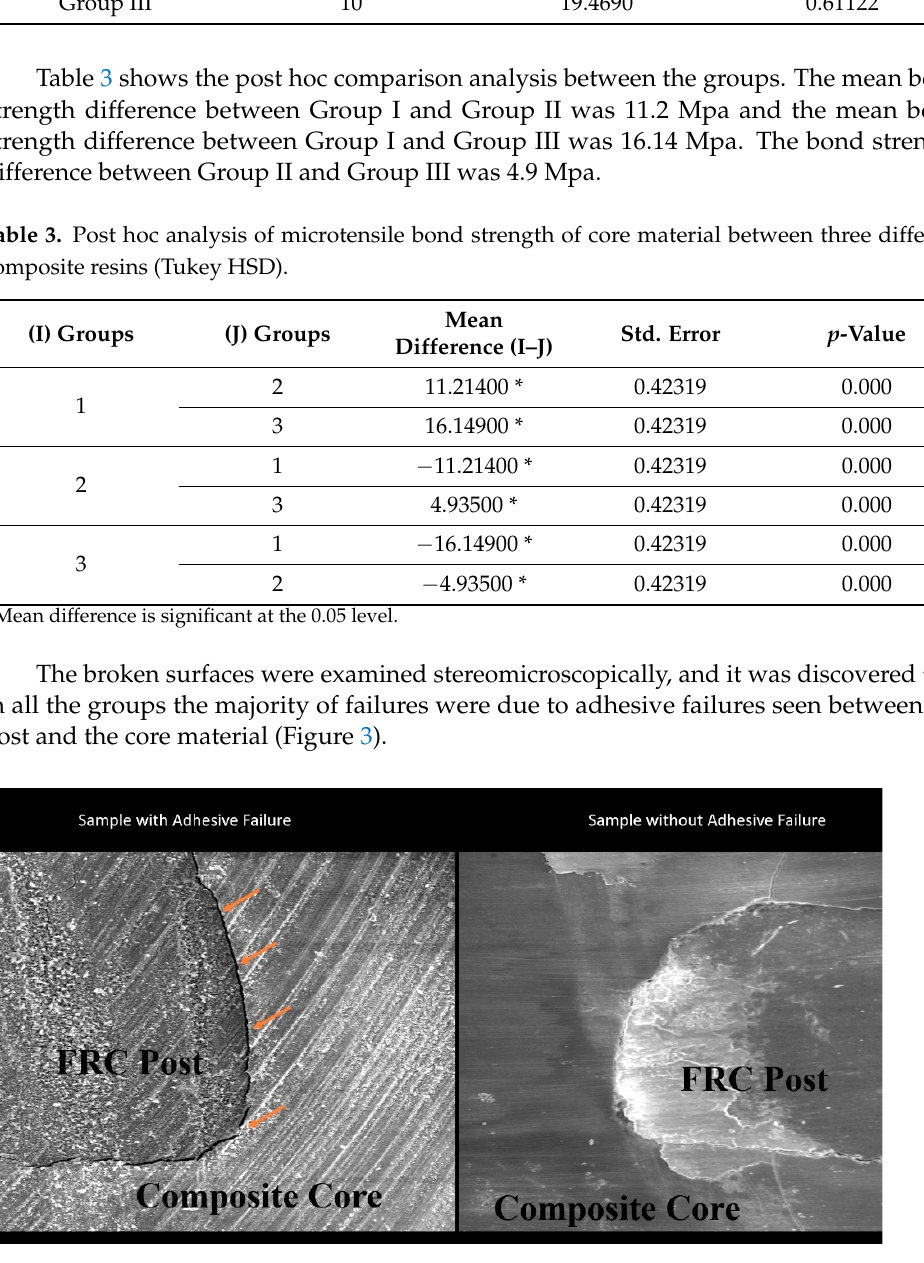
Figure 3. Stereomicroscopic image with 20× magnification of adhesive